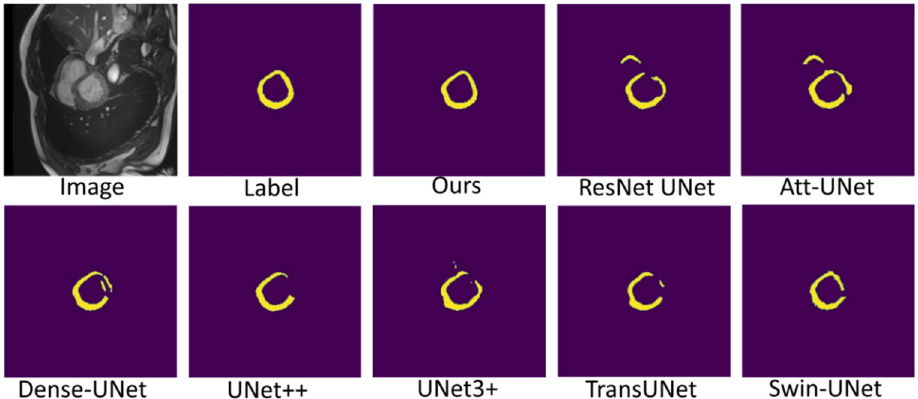
Figure 8. Comparison of myocardium (Myo) segmentation results.